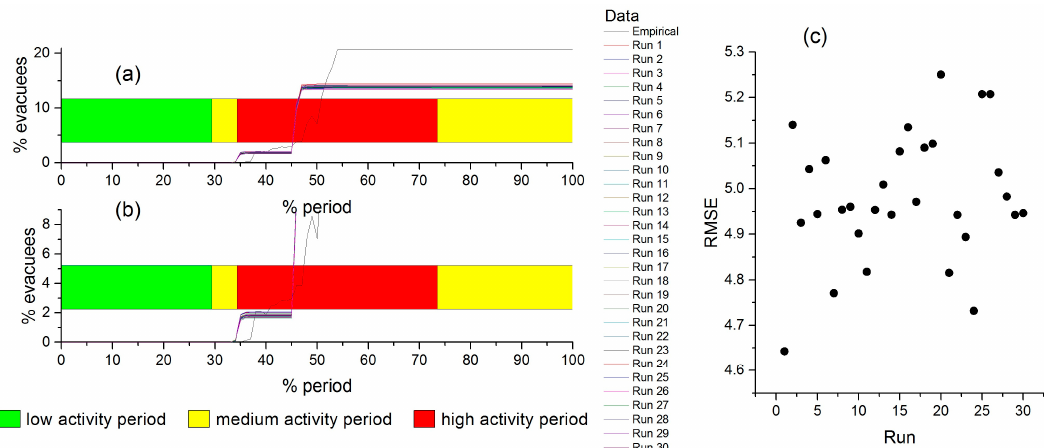
Figure 13. Temporal comparison of simulated and observed evacuee accumulation based on scenario 3: ( a ) overall comparison; ( b ) zoomed to the simulation outputs; and ( c ) RMSEs.